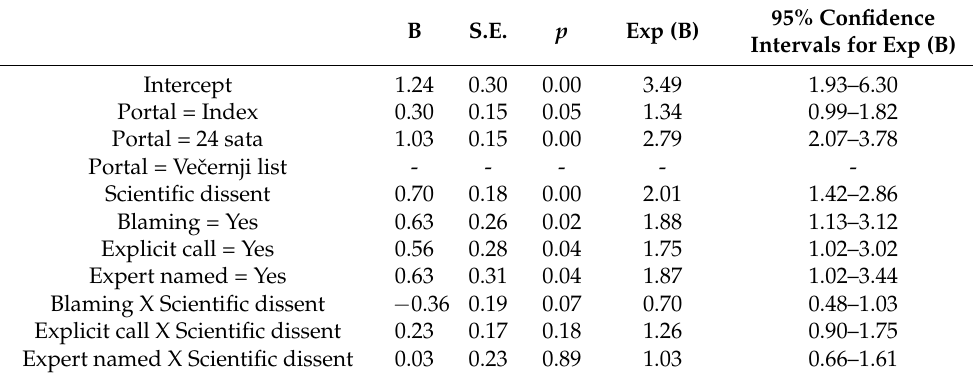
Table 5. Negative binomial regression—model